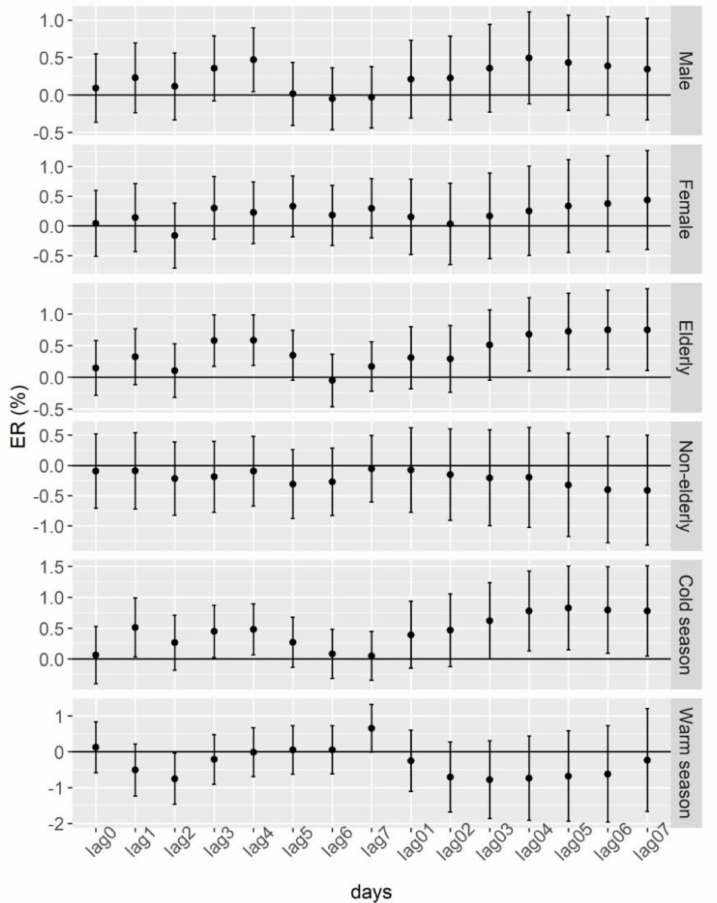
Figure 3. Associations of air NO 2 with daily incident stroke in different subgroups. ER: the percentage of increase in the daily incidence of stroke associated with one-unit (1 µ g/m 3 ) increase in NO 2 . Single- day lag effects: lag0, lag1, lag2, lag3, lag4, lag5, lag6, and lag7 (lag0 corresponds to the current-day air-pollutant concentration, and lag1 refers to the average concentration of air pollutants on the day before stroke incidence, etc.). Cumulative lag effects: lag01, lag02, lag03, lag04, lag05, lag06, and lag07 (the lag01 corresponds to the 2-day moving average concentration of air-pollutant concentrations